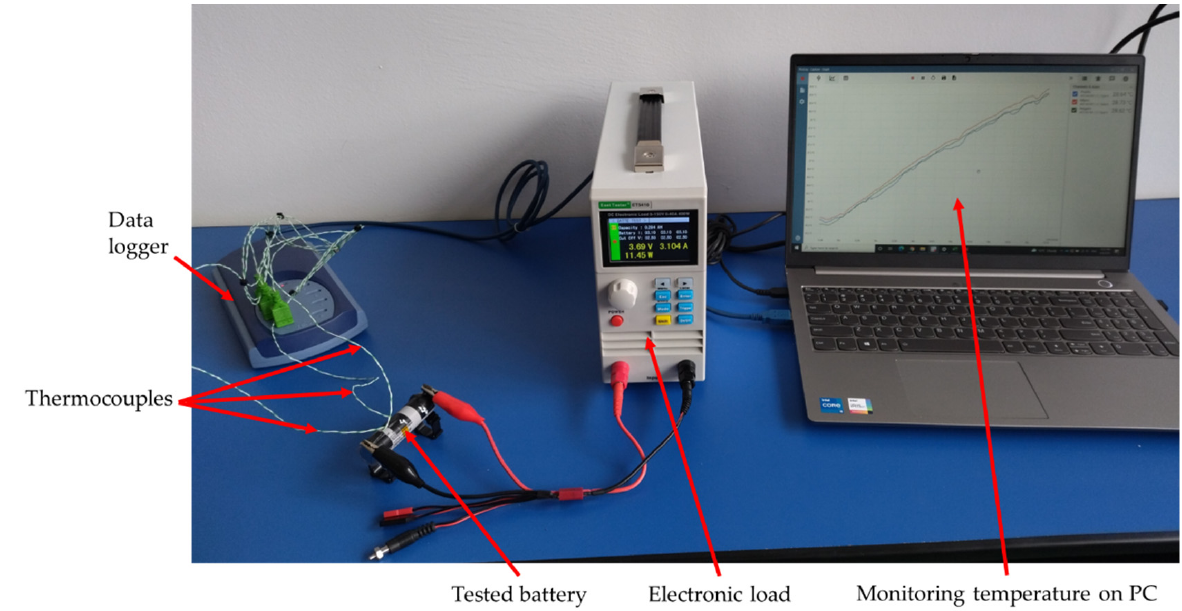
Figure 3. Experimental setup.